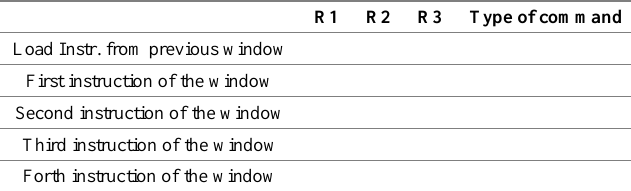
Table 1. Window checking structure of dependency of